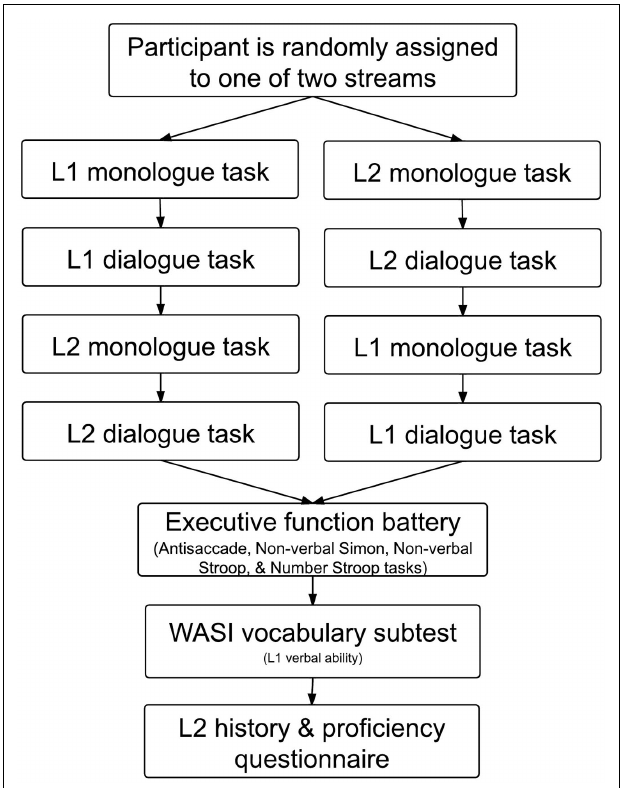
FIGURE 2 | Illustration of the procedure in the current